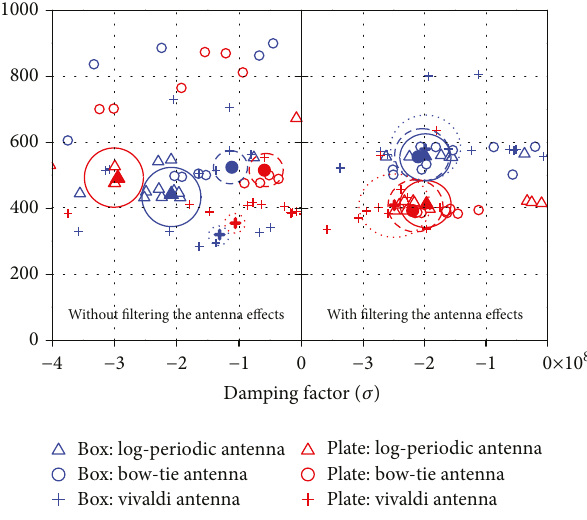
Figure 10: Selected poles of experimentations for target classi fi